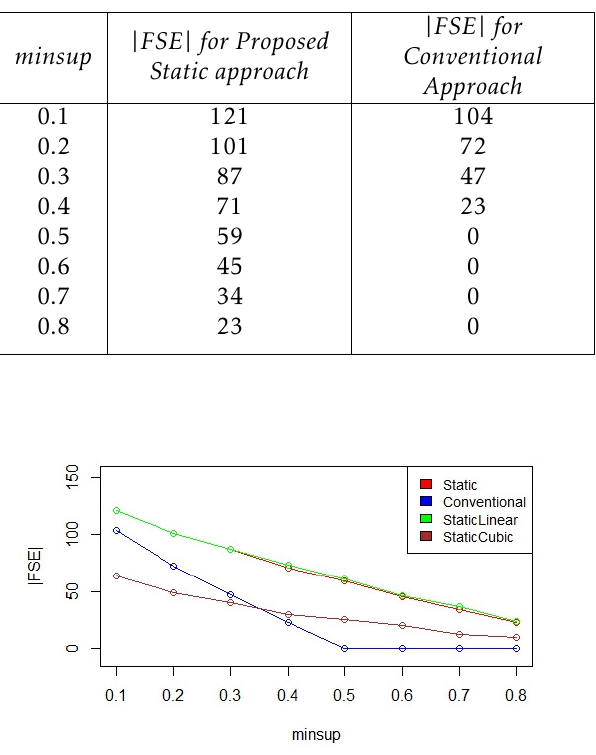
Figure 3. Number of frequent singleton edges ( | FSE | )